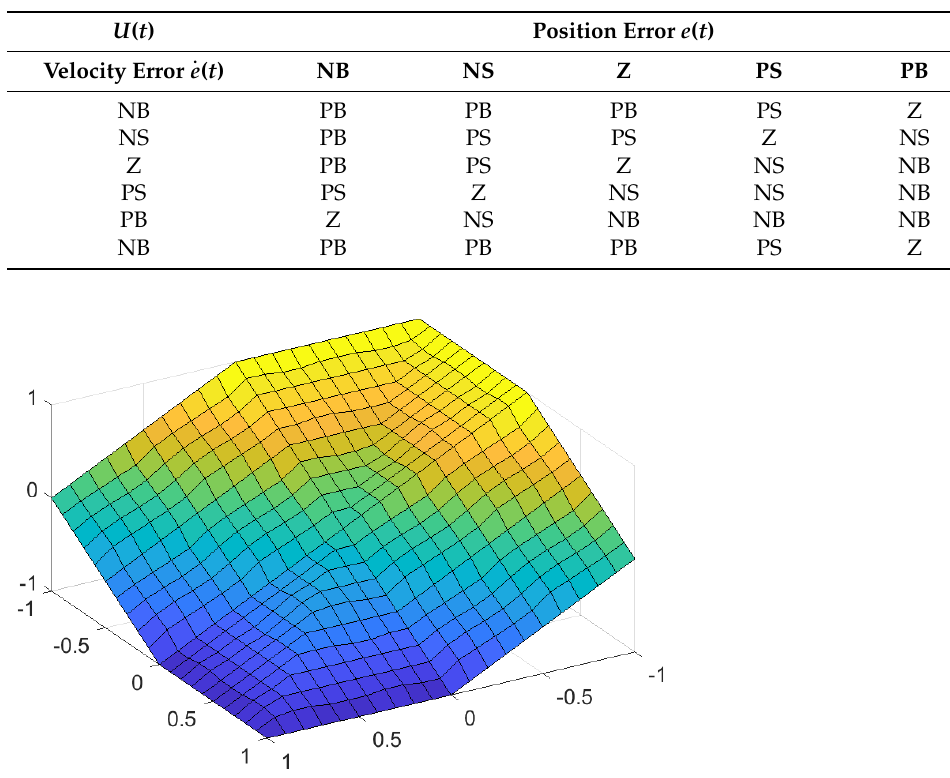
Table 3. Fuzzy rule base system.